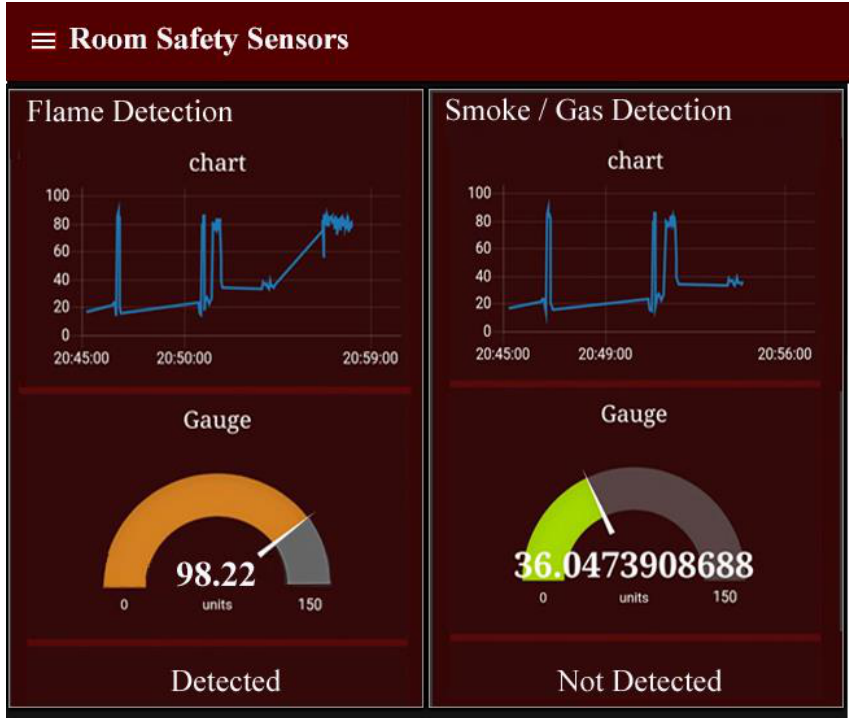
Figure 8. Dashboard of safety sensors in terms of graphs and gauges that are used for real-time monitoring to protect the property and human life from harm or damage. monitoring to protect the property and human life from harm or